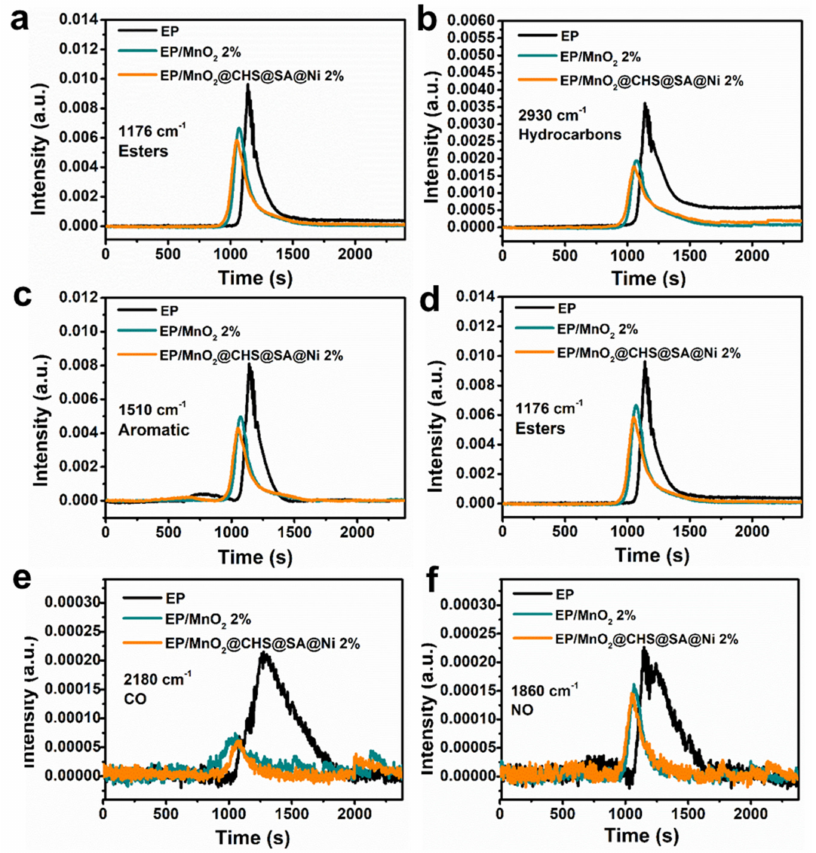
Figure 5. Absorbance spectra of pyrolysis products of pristine EP, EP/MnO 2 2% and EP/MnO 2 @CHS@SA@Ni 2% versus time: ( a ) Gram–Schmidt curves, ( b ) hydrocarbons, ( c ) aromatic compounds, ( d ) esters, ( e ) CO and ( f )